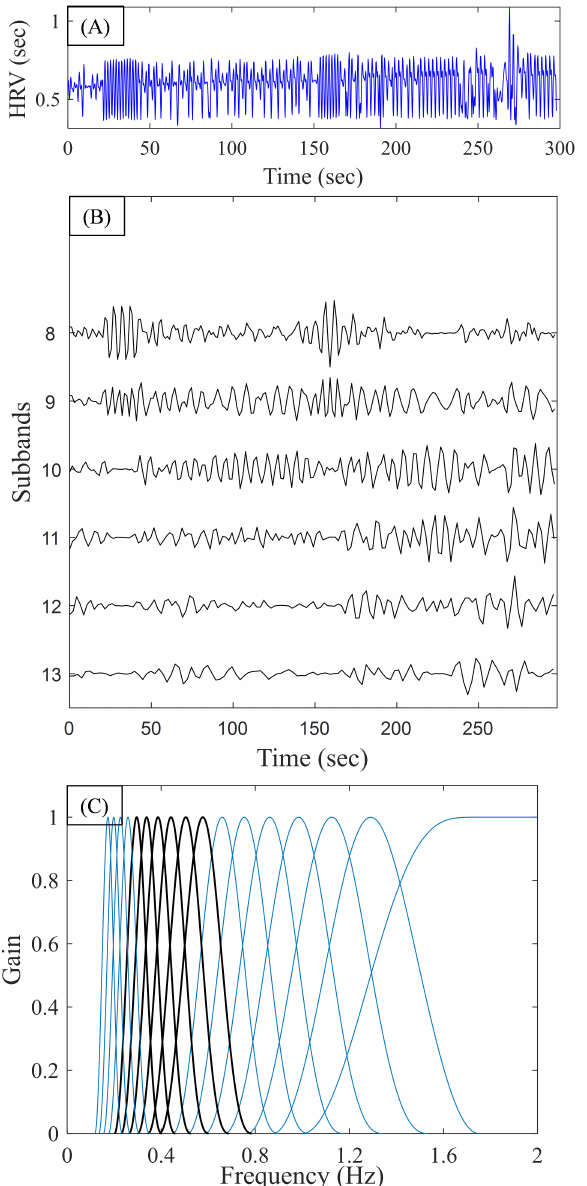
Figure 6. ( A ) Sample 5-min heart rate signal. ( B ) TQWT coefficients obtained from levels 8 to 13. ( C ) Frequency response of the TQWT transform with the selected parameters (normalized to have unity